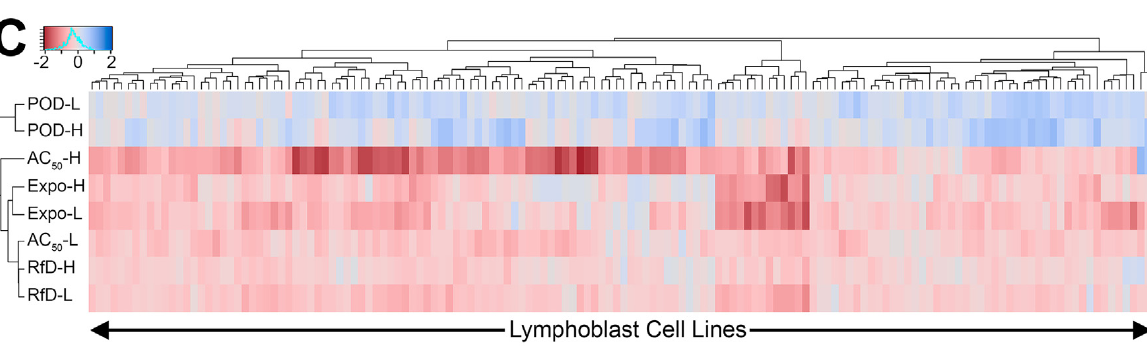
Figure 2. Comparison of mixture points of departure (POD = EC 10 ) measured and predicted by concentration addition (CA) for each individual cell line. ( A ) . Scatter plot of the median Bayesian posterior estimate of measured and CA-predicted EC 10 . ( B ). Distribution across individuals of Loewe Additivity Index (LAI) for each mixture. ( C ). Heatmap and hierarchical clustering of log 10 (LAI) across mixtures and individual cell lines. In panels ( A , B ), dashed line indicates equality, and light dotted lines indicates 10-fold differences in either direction. In panels ( B , C ), LAI < 1 (or log 10 (LAI) < 0) indicates greater-than-additive effects (“synergy”) and LAI > 1 (or log 10 (LAI) > 0) indicates less-than-additive effects (“antagonism”).